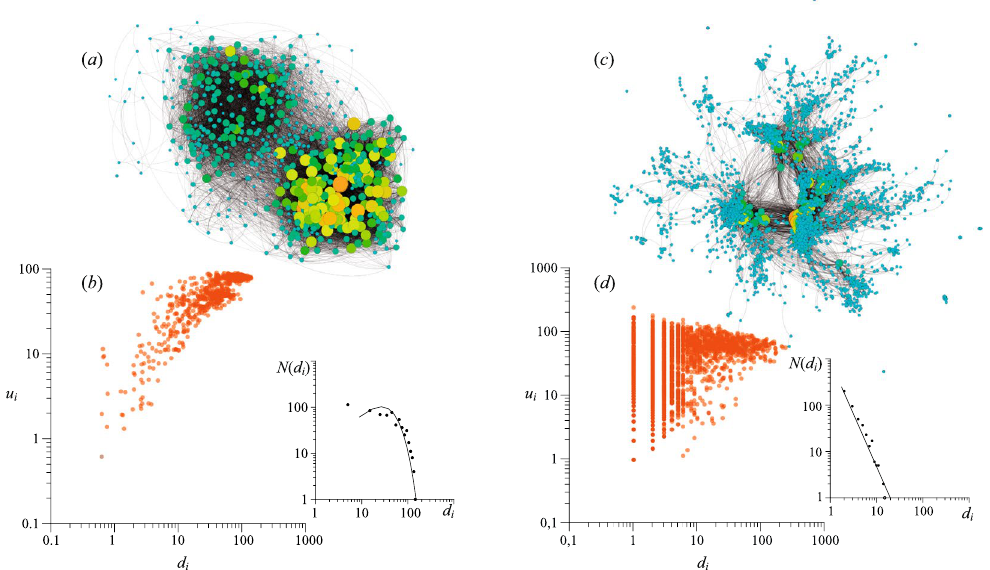
Figure 6. The network visualizations ( a , c ) and the ( d i , u i ) scatter plots ( b , d ) of two real-world networks: ( a , b ) the resting-state fMRI network of human brain 36 and ( c , d ) the global airline network from the website Openflight.org 37 . The assortativity coefficient is r = 0.3886 in panel a, and r = 0.0461 in panel c. The corresponding degree distributions are shown in the insets. Here, degree distribution in ( b ) is well fitted with Poisson law with 4 94 ξ =